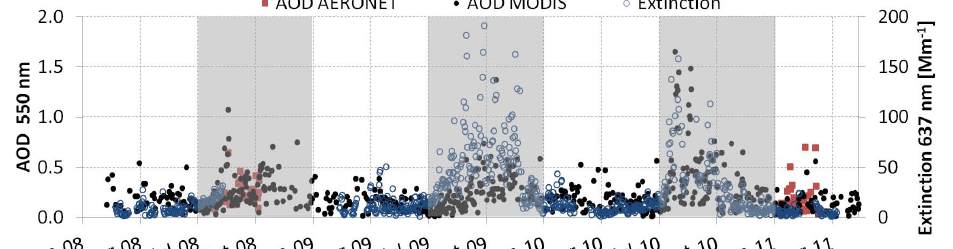
Fig. 6. Daily averages of aerosol optical depth (AOD) observations from MODIS (TERRA-AQUA), AERONET (Manaus) and in situ ex- tinction measurements above the canopy. AOD observations from MODIS were integrated inside an area with 40km radius around the in situ measurement site. AOD observations from AERONET are level 2.0 in 2008 Jul-Oct and level 1.5 in January–April 2011, and were interpolated to 550nm using AOD(500) and the ˚Angstr¨om exponent between 440 and 675nm. Shaded areas represent the dry season